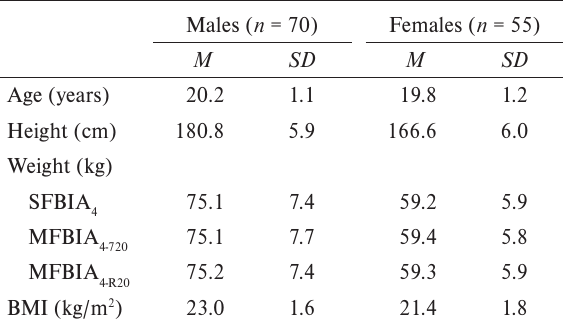
Characteristics of the monitored group